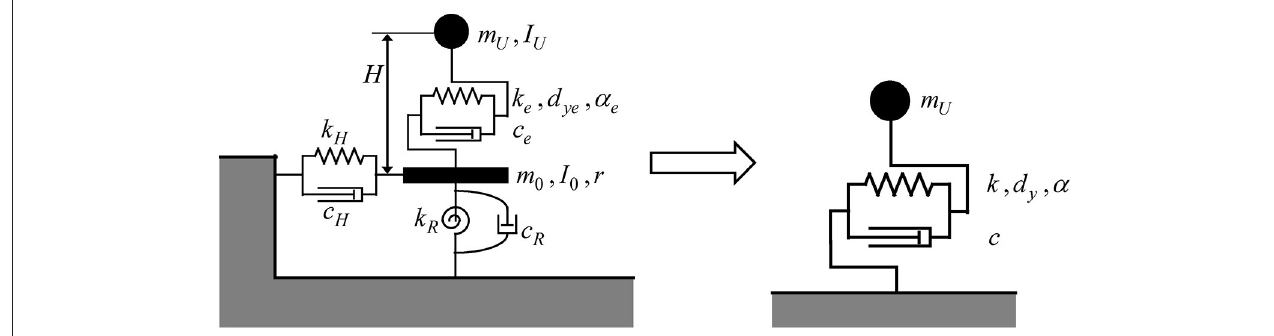
FIGURE 6 | Transformation of SDOF system on a swaying-rocking spring-dashpot system into an SDOF system.